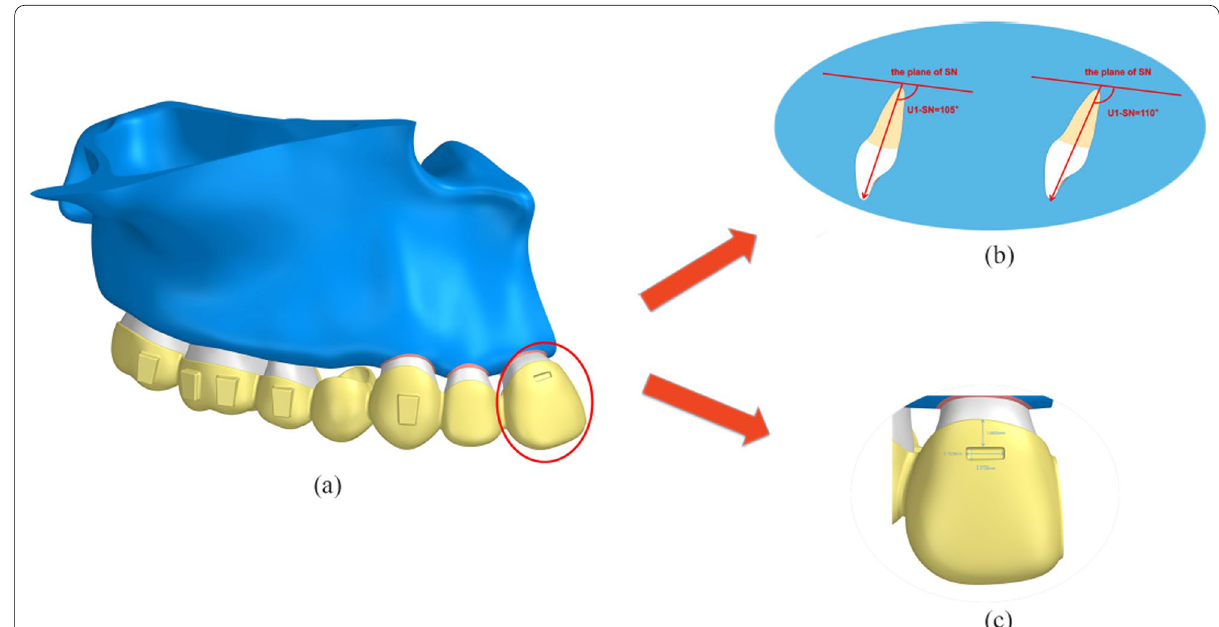
Fig. 1 Three-dimensional finite element model for incisor retraction in a case involving 1st premolar extraction. a Maxillary arch with 1st premolar removal with attachments on the vestibular surfaces of the crowns and a geometric model of the clear aligner. b Different axial inclinations of the upper central incisor (U1-SN 105°; U1-SN 110°). c The position and size of the power = =